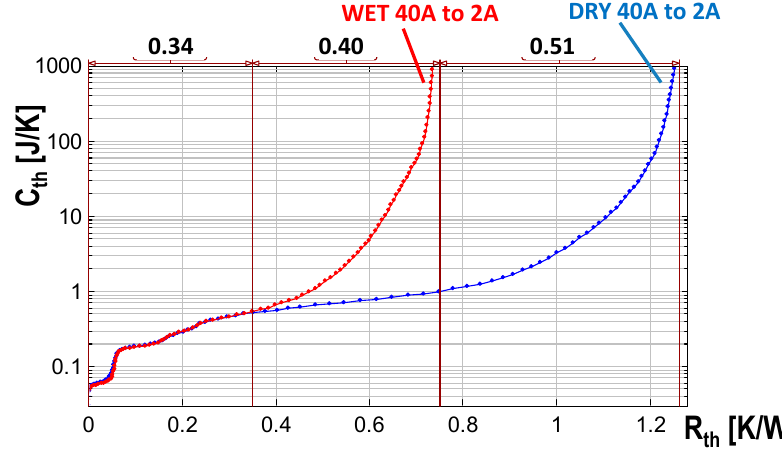
Figure 12. Structure functions: component on a cold plate at “dry” and “wet” boundary conditions (from [11).